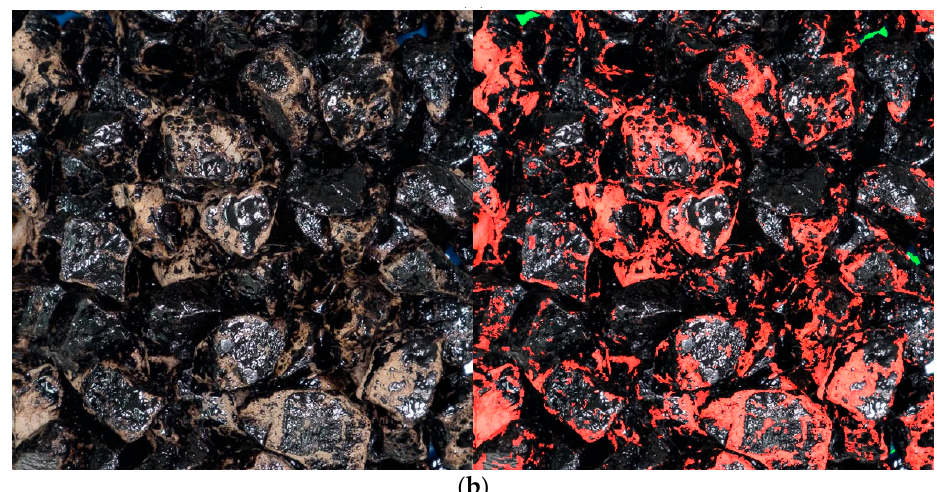
Figure 3. Exemplary results of PMB-B-N-H-Q experiment image analysis: ( a ) first photograph—78.7% coverage; ( b ) second photograph after sample flipping and rearranging of aggregate particles—79.3% coverage; final sample coverage—79.0%.